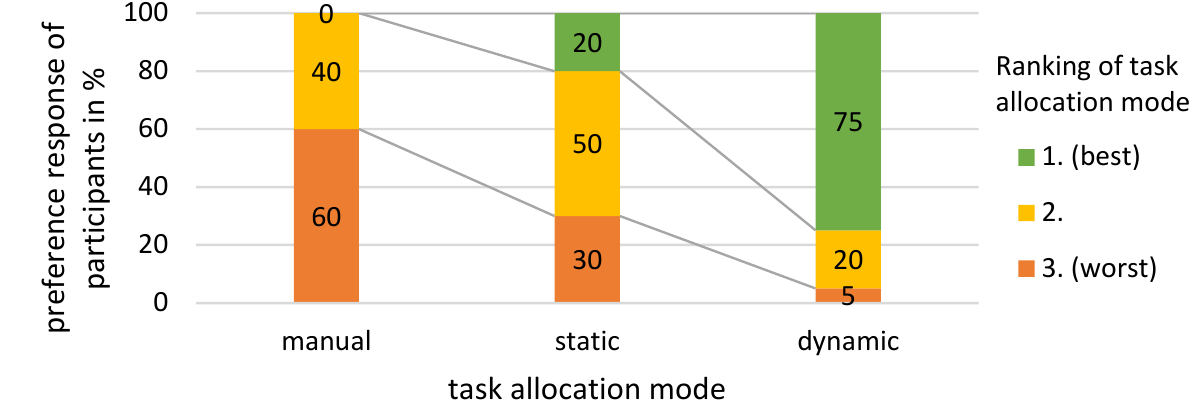
Figure 22. Subjects’ ranking of preferred task allocation Figure 22. Subjects ’ ranking of preferred task allocation mode.